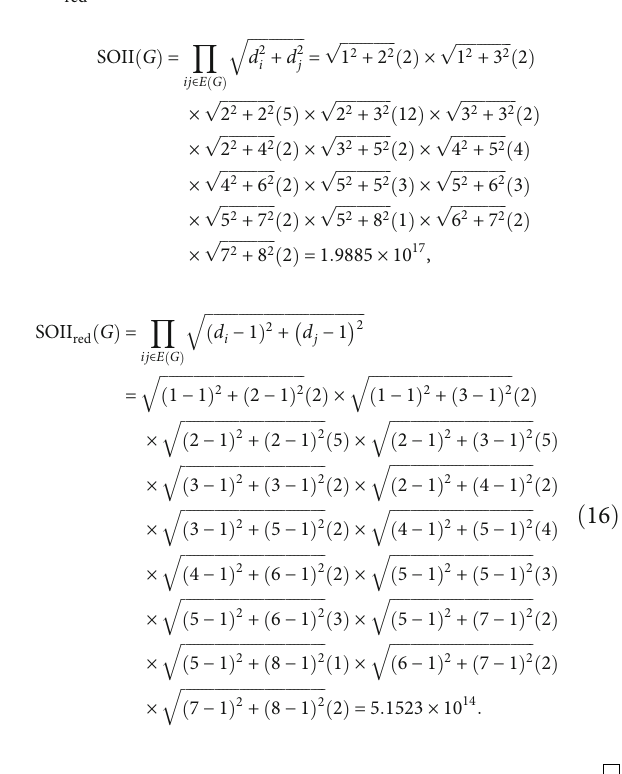
ffiffiffiffiffiffiffiffiffiffiffiffiffiffiffiffiffi 1 + 3 − 2 ffiffiffiffiffiffiffiffiffiffiffiffiffiffiffiffiffi 3 + 3 − 2 ffiffiffiffiffiffiffiffiffiffiffiffiffiffiffiffiffi 4 + 5 − 2 ffiffiffiffiffiffiffiffiffiffiffiffiffiffiffiffiffi 5 + 6 − 2 ffiffiffiffiffiffiffiffiffiffiffiffiffiffiffiffiffi 6 + 7 − 2 p 1 × 3 p 3 × 3 p 4 × 5 p 5 × 6 3 ð Þ 5 + 6 p 6 × 7 ð 12 Þ